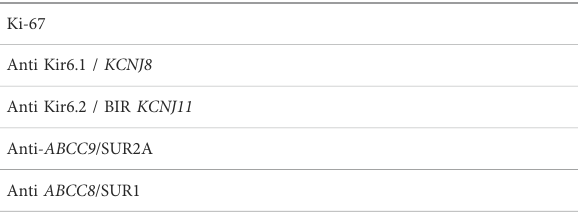
TABLE 2 Immunohistochemical markers used in the female canine breast